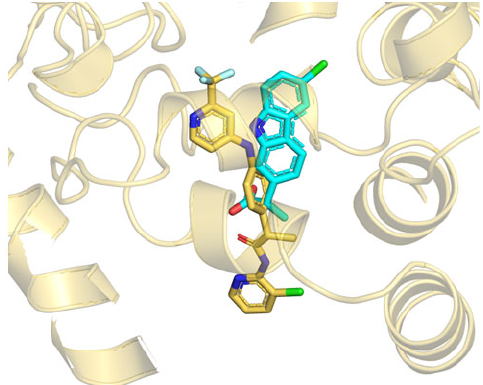
Figure 6. Superposition between the B3db1 binding mode of TPA14 in r FAAH (yellow stick) and the crystal structure of carprofen (cyan stick) (PDB: 4DO3), close to the MAC